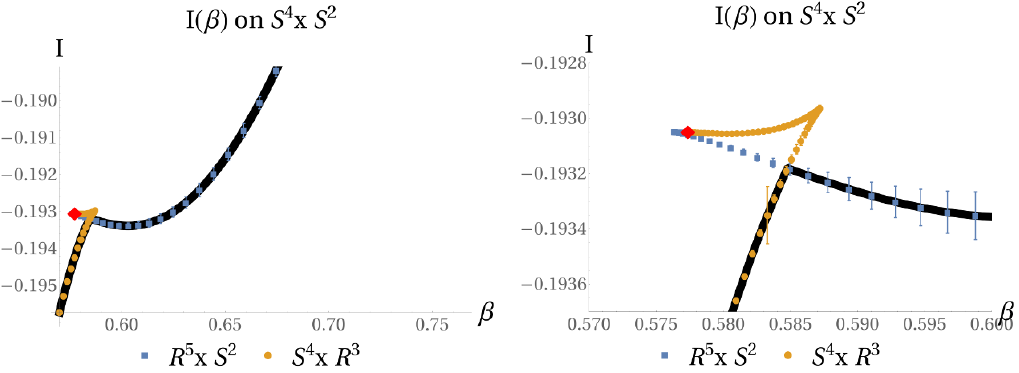
Figure 12 . The action I as a function of the ratio of radii (cid:12) for both topologies with conformal boundary S 4 (cid:2) S 2 . The red diamond is the analytical calculation for the singular ratio (cid:12) s = 0 : 577, and the black line follows the dominant solution for each ratio (cid:12) . We see that there is a (cid:12)rst order phase transition at (cid:12) c = 0 :